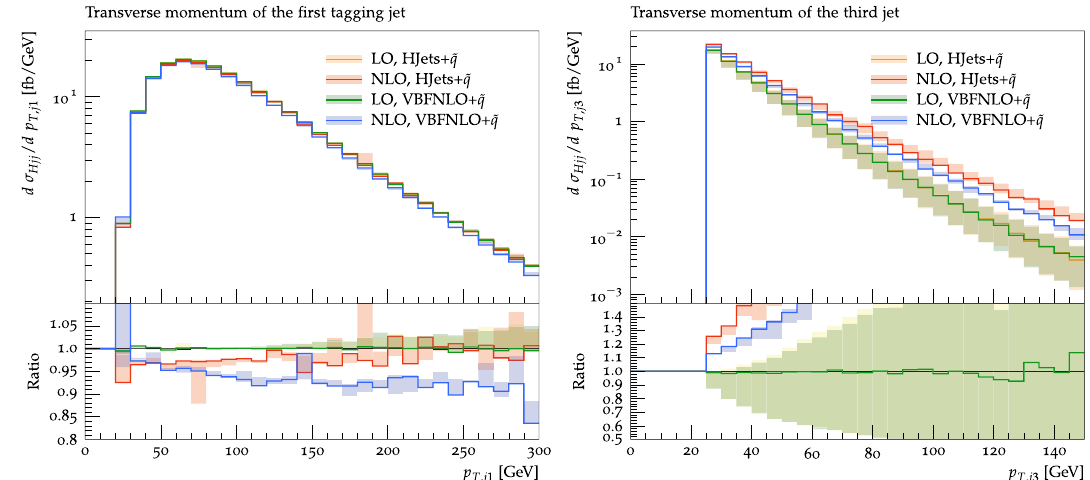
Fig. 9 Transverse-momentum distribution of the hardest jet (left) and the third jet (right) in the loose selection of Sect. 4.1.3, comparing HJets and VBFNLO with the angular ordered shower of HERWIG7 .